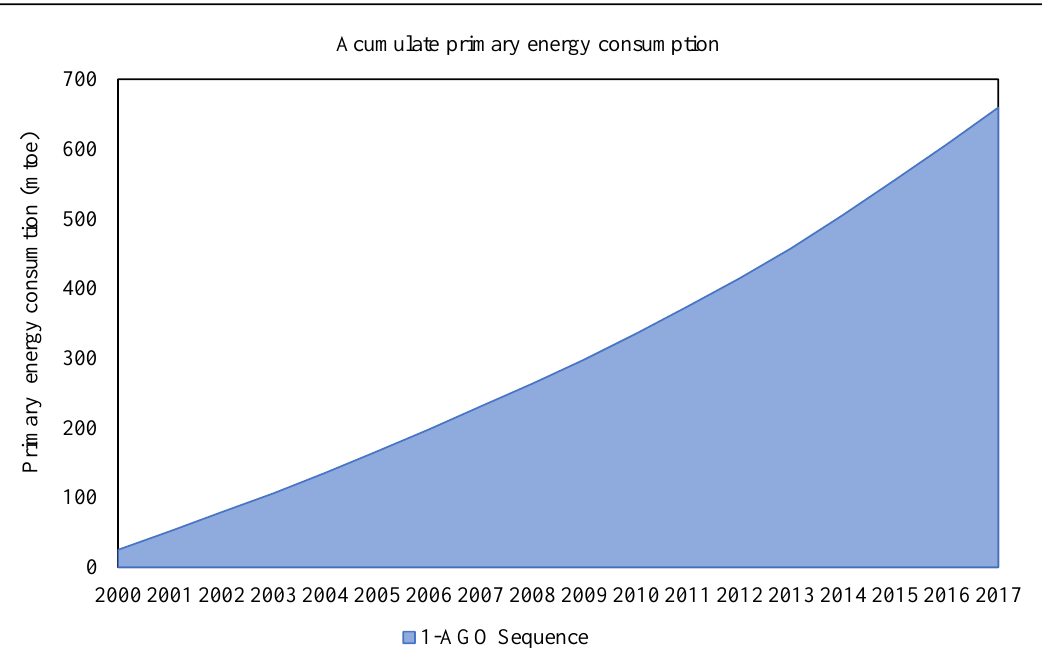
Figure 3. 1-AGO Sequence of primary energy consumption in Eastern Africa.